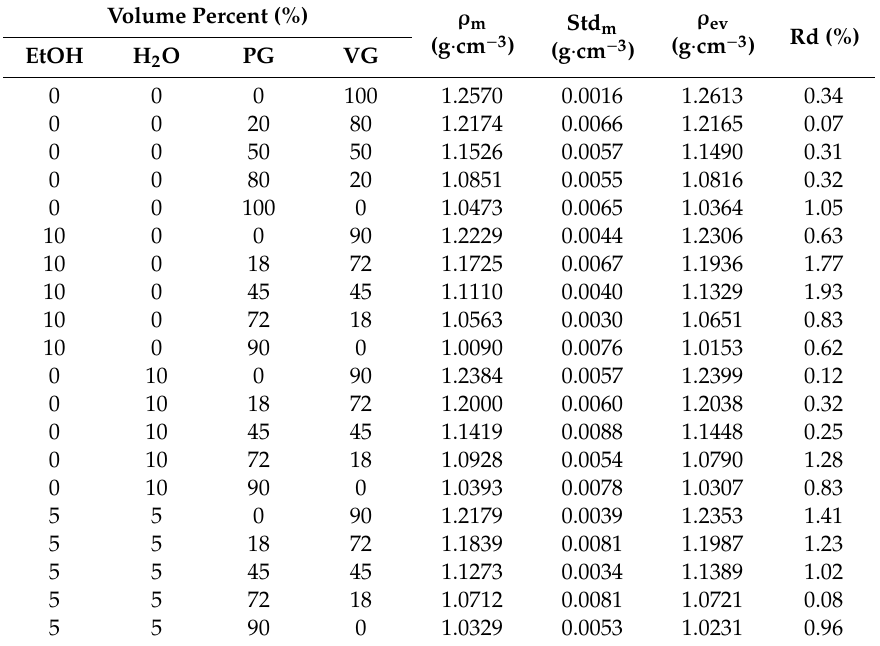
Table 5. Composition, measured density ( ρ m ) and standard deviations (Std m ) over the triplicate, theoretical densities ( ρ ev ) (Equation (1)) and relative deviations (Rd) between the measured and theoretical densities of the tested PG–VG binary systems at 20 ◦ C.